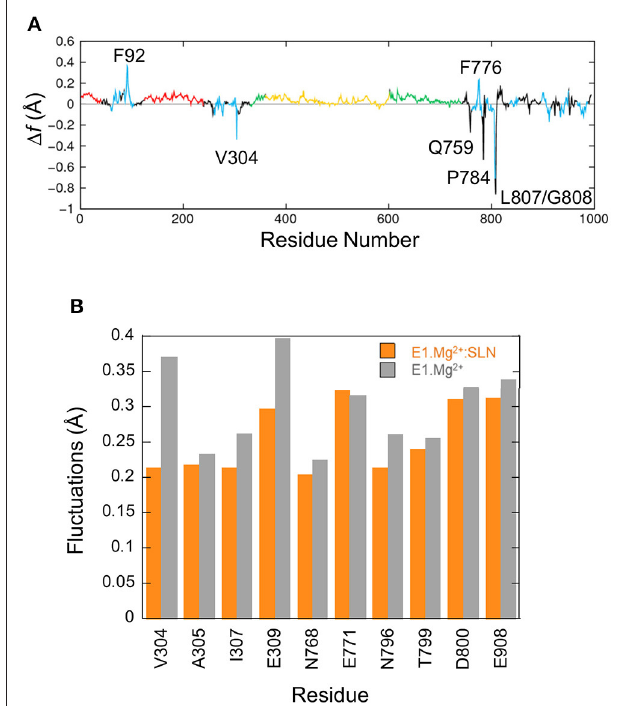
FIGURE 5 | Fluctuations of residues. (A) 1 f , the difference of fluctuations of the C α atoms calculated from the 200 modes. The fluctuations of E1.Mg 2 + were subtracted from those of E1.Mg 2 + :SLN. The same color code as in Figure 1A is used to delimit the domains. (B) Average fluctuations of the Ca 2 + chelating groups, i.e., the carboxyl, hydroxyl or carbonyl groups of the residues in the two Ca 2 + binding sites. Orange bars for E1.Mg 2 + :SLN and gray bars for E1.Mg 2 +